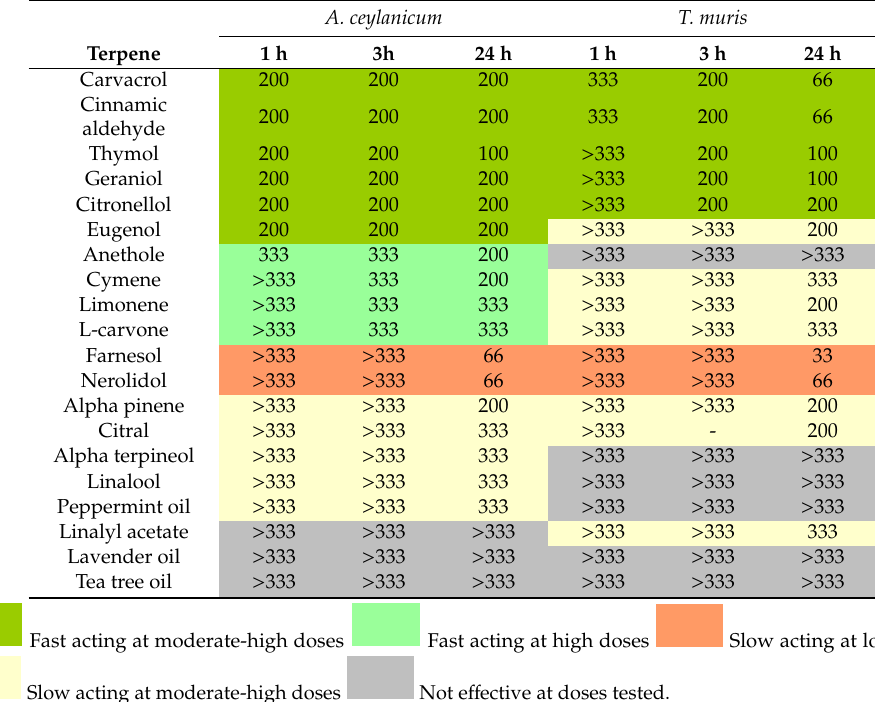
Table 1. Minimum effective doses and classification of YP–terpenes against A. ceylanicum and T. muris.